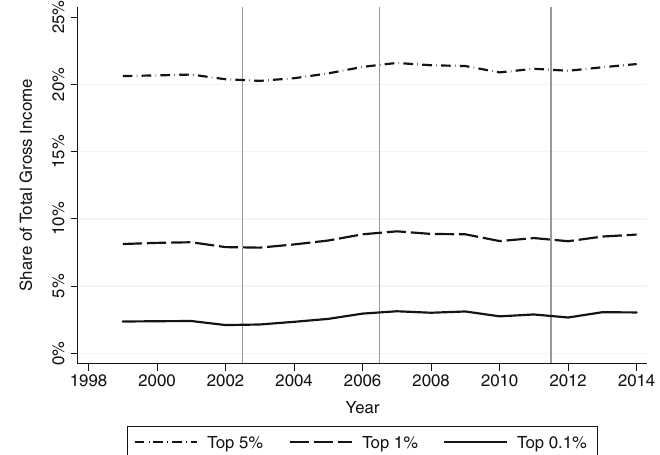
Fig.4 Topincomeshares,1999–2014.Notes:Thisfigureshowstheevolutionoftopincomesharesannually for the period 1999–2014. For each year, we calculate the total amount of gross income earned by